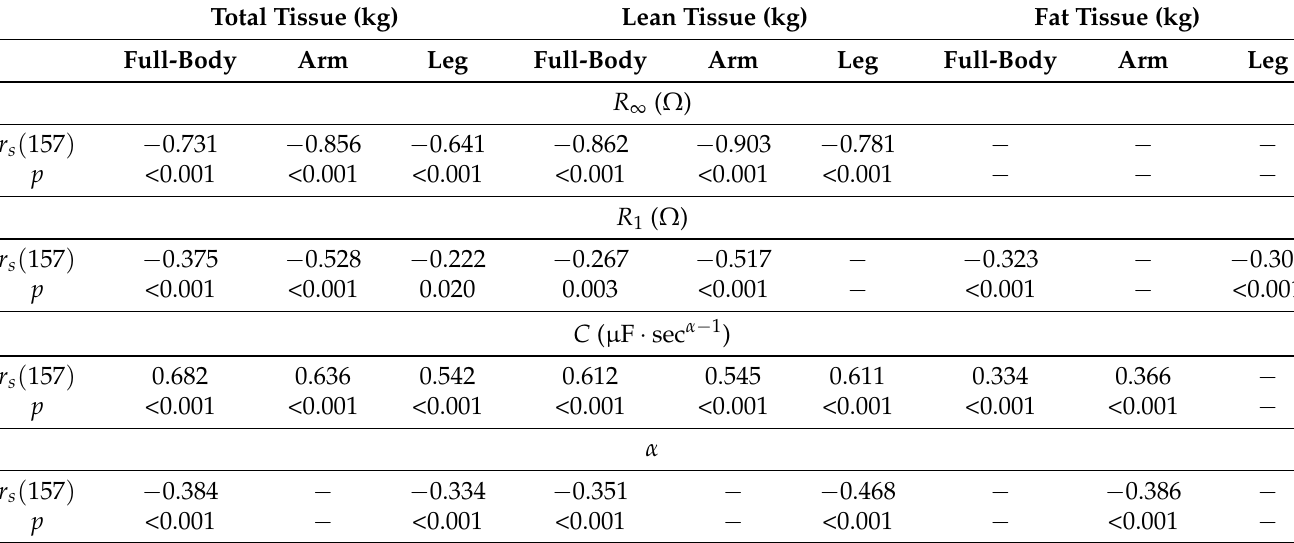
Figure 7. Scatterplots of ( a ) R ∞ , ( b ) R 1 , ( c ) C , and ( d ) α vs. total segmental tissue, lean tissue, and fat tissue for right-side full body (black), right arm (blue), and right leg (red) impedance datasets. Table 2. Spearman-rank correlation coefficients ( r s ) and statistical significant ( p ) between Cole-impedance parameters and total/lean/fat tissue masses for segmental